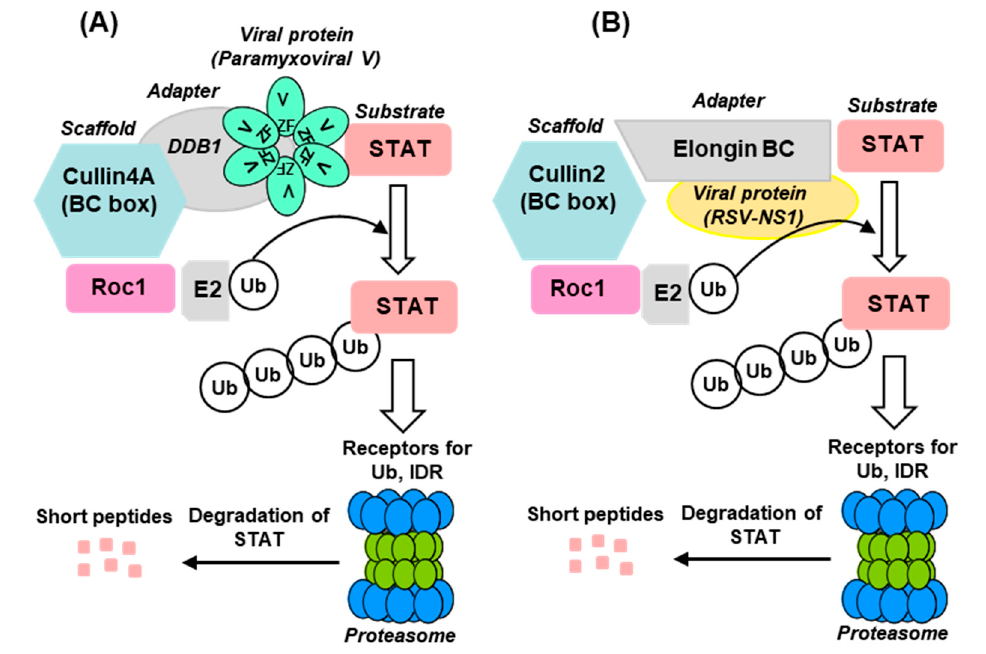
Figure 9. Working model of representative virally assembled proteasome complexes (VADCs) of the V protein ( A ) and RSV NS proteins ( B ). The various subunits of the VADC are indicated, which include the CRL components as shown, i.e., CUL4A–Roc1 E3 ligase and DDB1 as adaptor protein in the V protein VADC ( A ), and CUL2–Roc1 E3 ligase (in HEp-2 cells) and elongin BC in the RSV NS1- based VADC ( B ). The viral protein serves as the STAT2-recognition protein. However, as described in Section 2.3.2, V proteins also have an intrinsic E3 ligase activity, thus serving both as a substrate recognition protein and an E3 ligase. It is unclear whether the viral NS proteins act in both capacities since their E3 ligase activity remains to be characterized in greater detail. Among the cytomegalo- viruses (not shown here, but detailed in Section 2.3.5), the M27 protein of mouse CMV and the non- homologous pUL145 protein of human CMV both use DDB1 as adapter and the CUL4A/B-Roc1 E3 ligase for STAT2 ubiquitylation and eventual degradation, which is reminiscent of the V proteins ( Panel A ). In all cases, the ultimate result is ubiquitylation of STAT2, followed by recognition of an